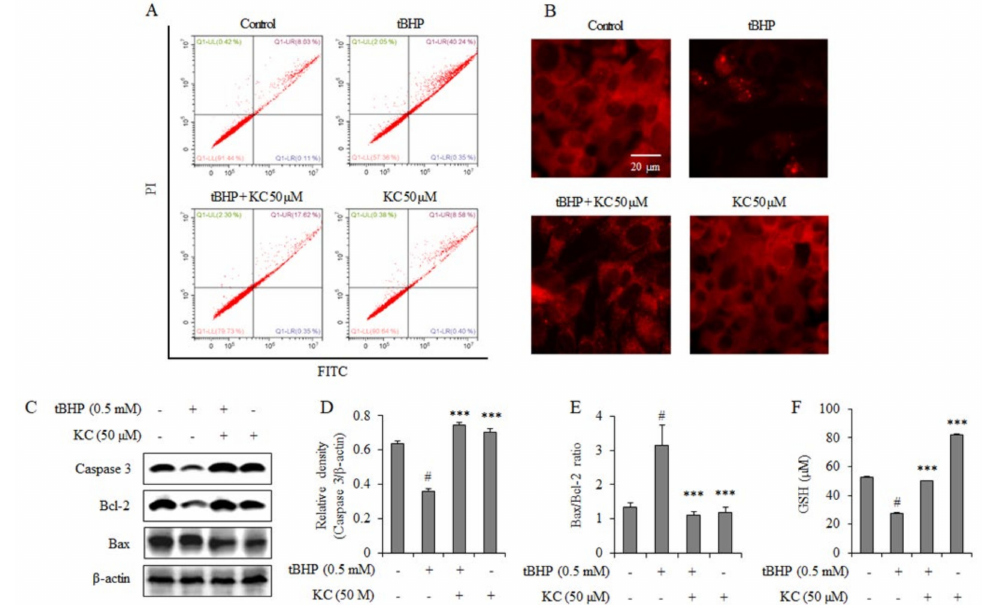
Figure 2. Effect of kushenol C on apoptosis, mitochondria membrane potential, caspase-3 and Bax/Bcl-2 expressions in tBHP-treated HEPG2 cells. Cells were preincubated with or without KC for 1 h and then treated with or without 0.5 mM of tBHP for 12 h. ( A ) Apoptosis assay was per- formed using an MEBCYTO (registered trademark of MBL International Corporation (Woburn, Ma, USA)) Apoptosis Kit. ( B ) Immunofluorescence staining was performed using a JC-1 mitochondrial membrane potential kit. ( C ) Caspase-3, Bcl-2, and Bax protein expression levels were investigated by Western blot assay and the band densities were analyzed using ImageJ analysis software, with respect to actin ( D , E ). ( F ) Intracellular glutathione (GSH) was measured using a Cayman assay GSH assay kit. Error bars represent the mean ± SD, # p < 0.001 vs. Control, *** p < 0.001 vs. tBHP-only treated